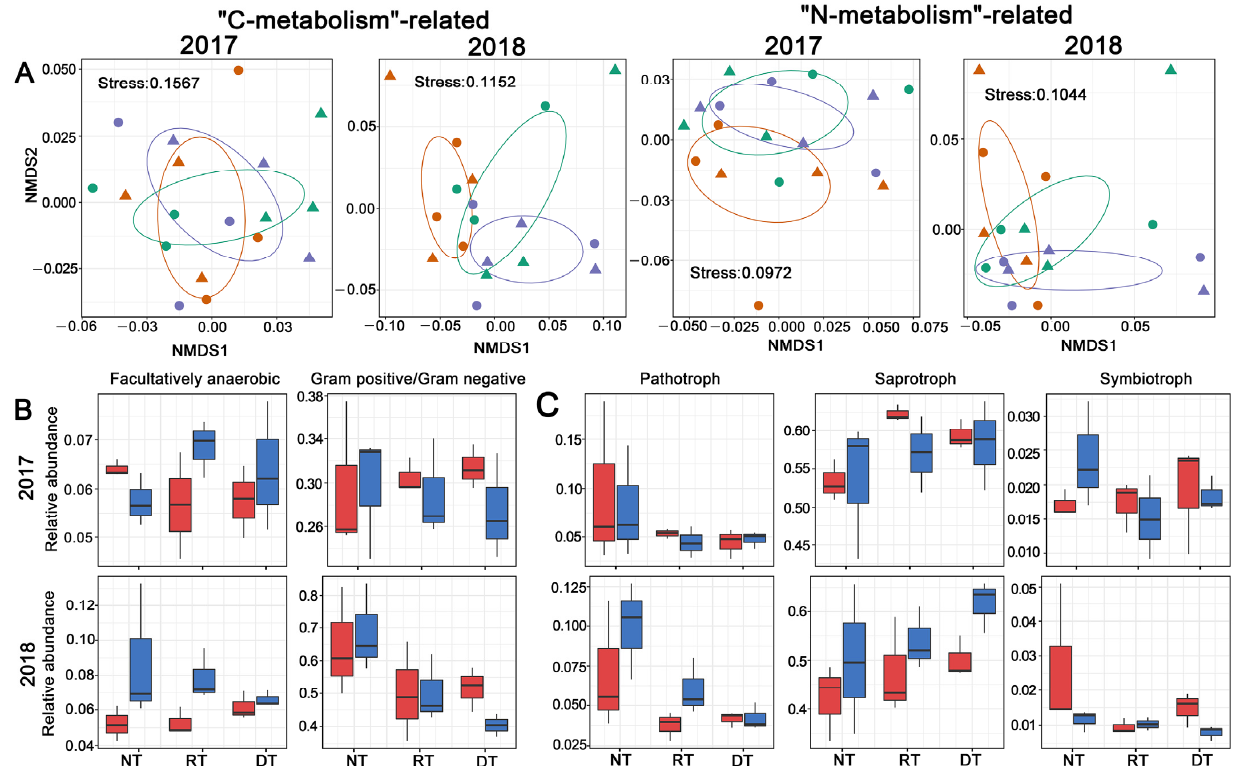
Figure 7. ( A ) Non-metric multidimensional scaling (NMDS) of the soil bacterial community upon “carbon metabolism” and “carbon metabolism” categories among treatments, triangle: residue removal; circle, residue retention; ( B ) relative abundance of facultative anaerobic and Gram-positive/Gram-negative ratio predicted by BugBase among treatments; ( C ) relative abundance of pathotrophs, saprotrophs and symbiotrophs predicted by FUNGuild among the treatments. Purple; no tillage; orange, rotary tillage; green, deep tillage; red: residue removal; blue, residue retention.